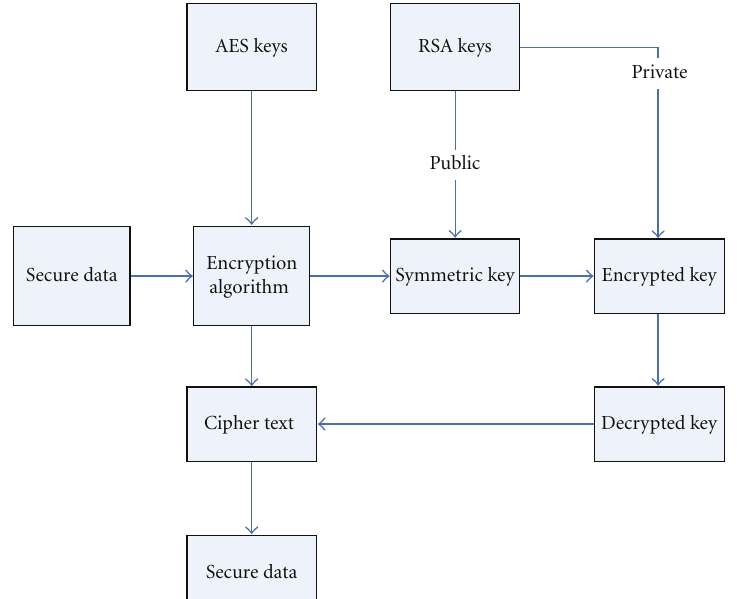
Figure 1: Block diagram for the double encryption.